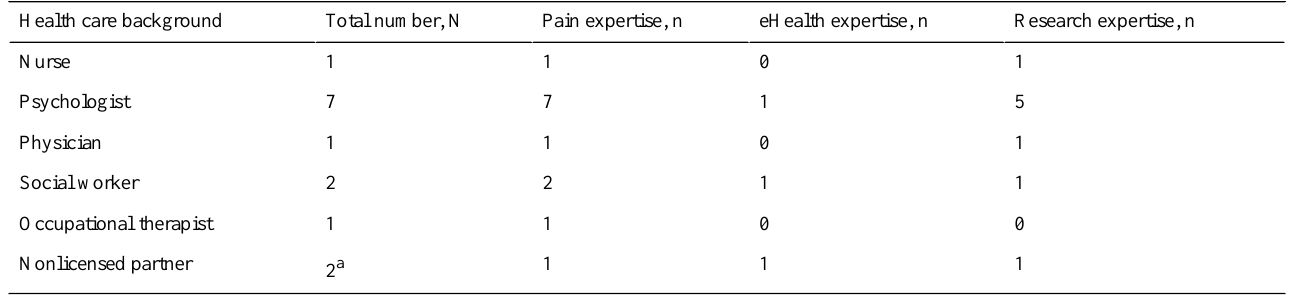
Table 2. Overview of background and experience of participants from collaborating institutions (N=14).